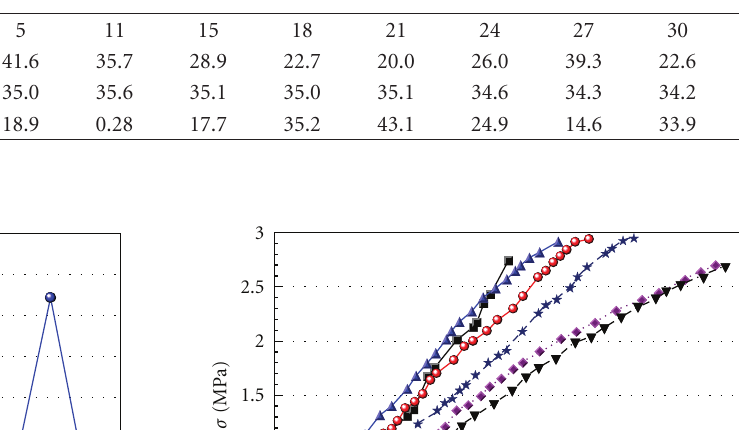
Table 4: Experimental data and model calculation results.